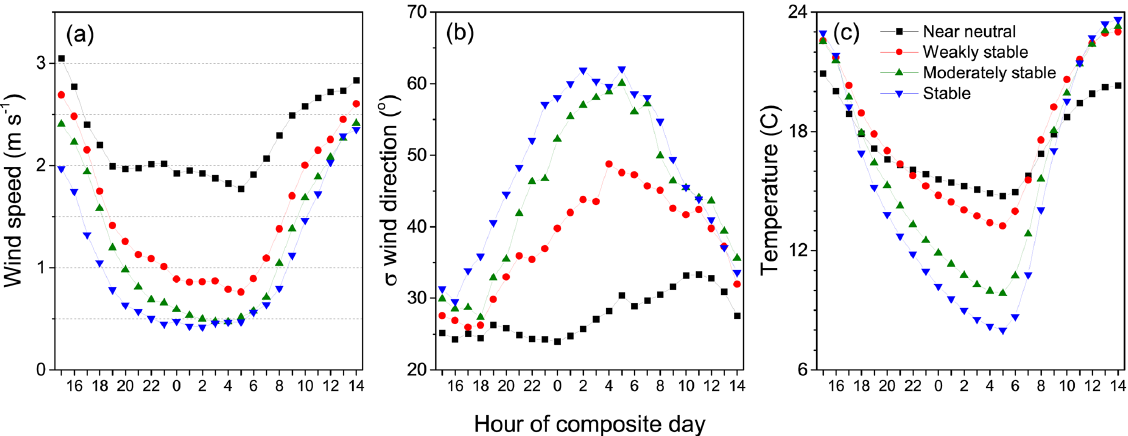
Figure 8. Mean hourly diurnal composite plots of (a) 10 m wind speed, (b) 10 m standard deviation of wind direction, and (c) 5m air